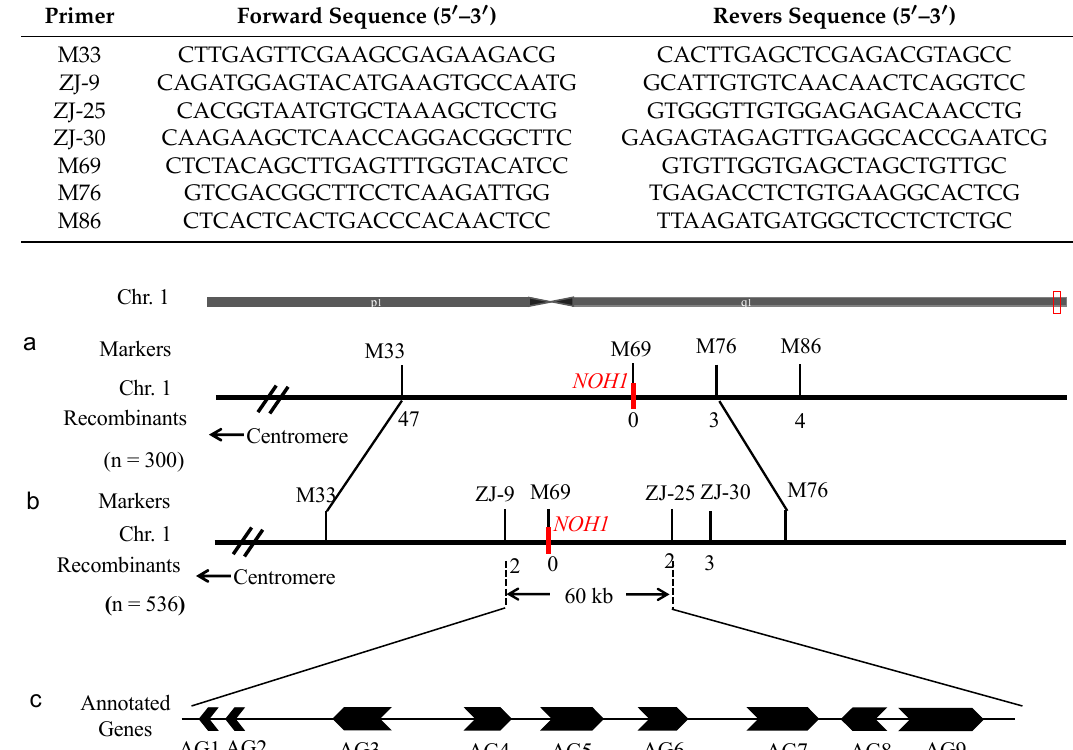
Figure 5. Localization of the target gene NOH1 on Chromosome 1 (Chr.1) of rice. ( a ) Primary mapping of NOH1 on chromosome 1 based on 300 individuals; ( b ) NOH1 was fine-mapped to an interval of 60 kb by 536 individuals; ( c ) Nine genes were annotated on the 60 kb region. AG1: miR172b ; AG2 : miR806a